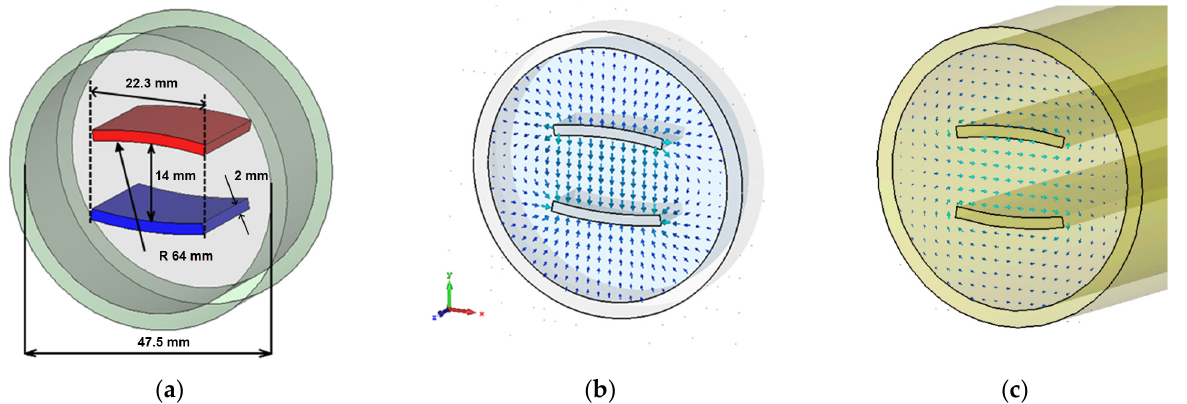
Figure 3. Transverse profile of the stripline kicker electrodes ( a ), electric ( b ) and magnetic ( c ) field maps.